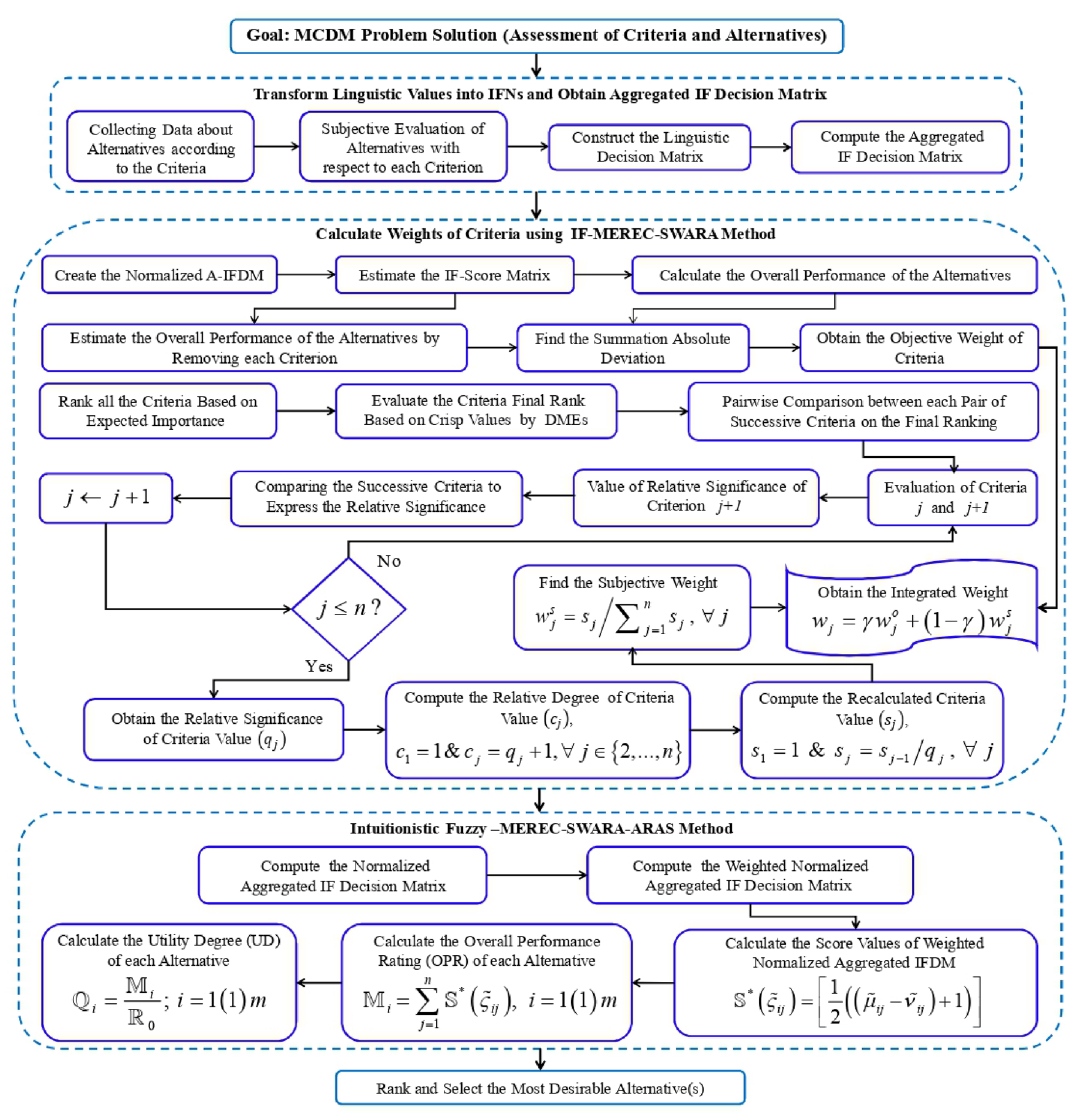
Figure 2. Diagrammatic representation of IF-MEREC-SWARA-ARAS